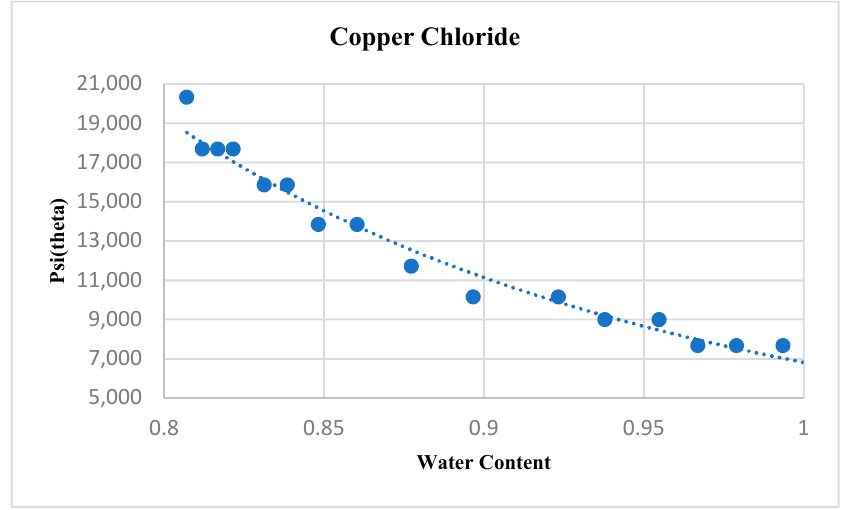
Figure 4. Decay model for copper chloride .